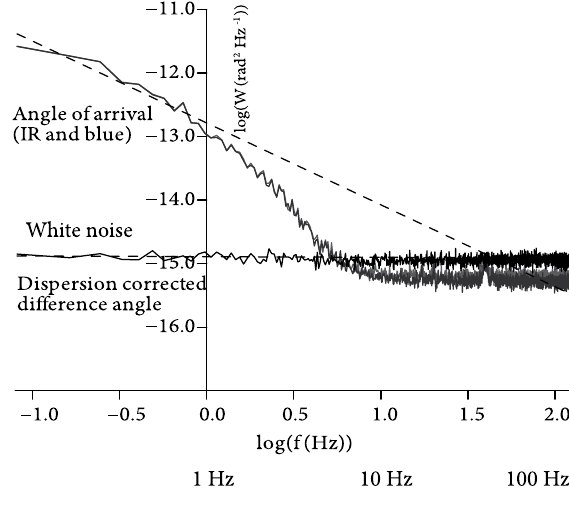
Fig. 8. Power spectra of the observed and dispersion corrected angle (Böckem 2001)